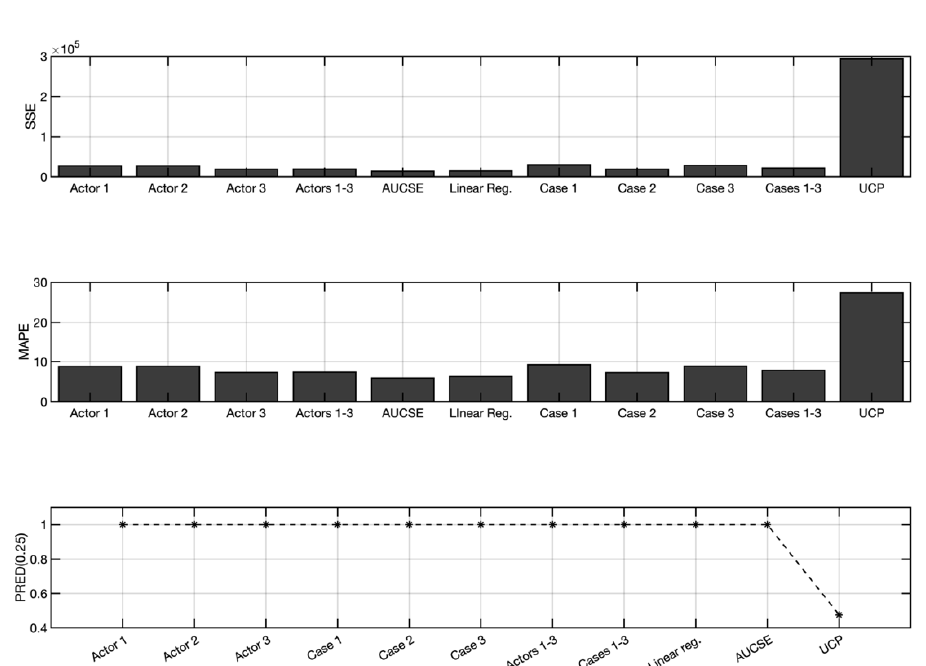
Figure 17. Comparison of the sum of squared errors (SSE), mean absolute percentage error (MAPE), and PRED (0.25) value for linear regression models.